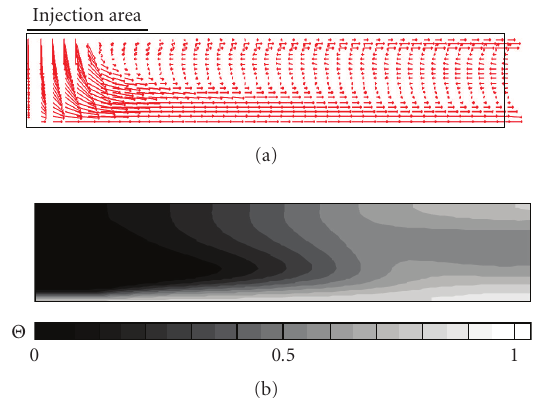
Figure 9: Velocity and temperature distributions in rotating disks for h/D i = 0 . 10 and Re =